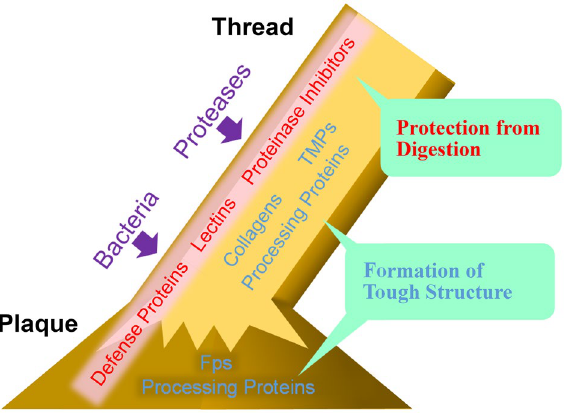
Figure 4. Strategy of the green mussel to form a tough, durable byssus, suggested by whole-genome and transcriptome analyses. Major genes expressed exclusively in the foot were classified into two major categories: genes encoding structural proteins (collagens, TMPs, and foot proteins) and processing proteins, including modification and polymerization enzymes and transport proteins, and those encoding proteins that protect the byssus from attack by bacteria and